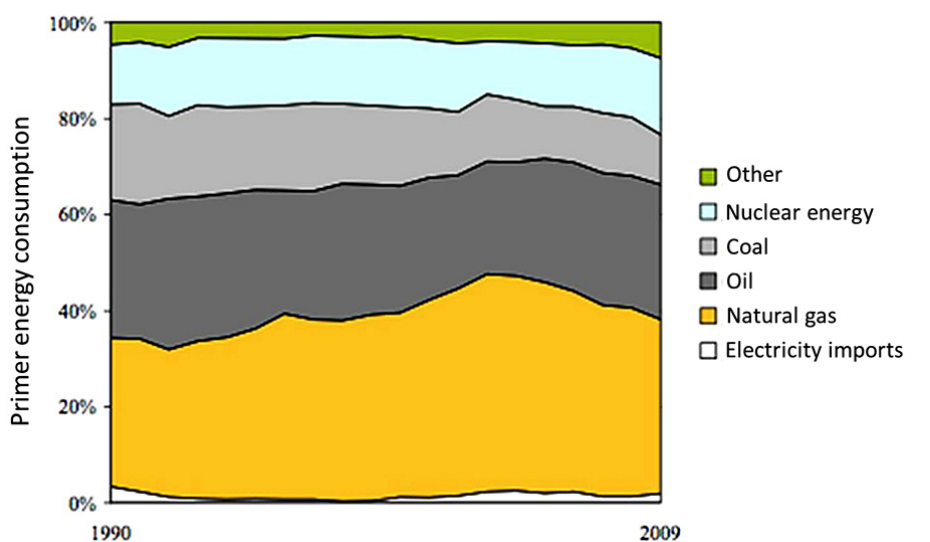
Figure 2. The structure of primary energy consumption in Hungary